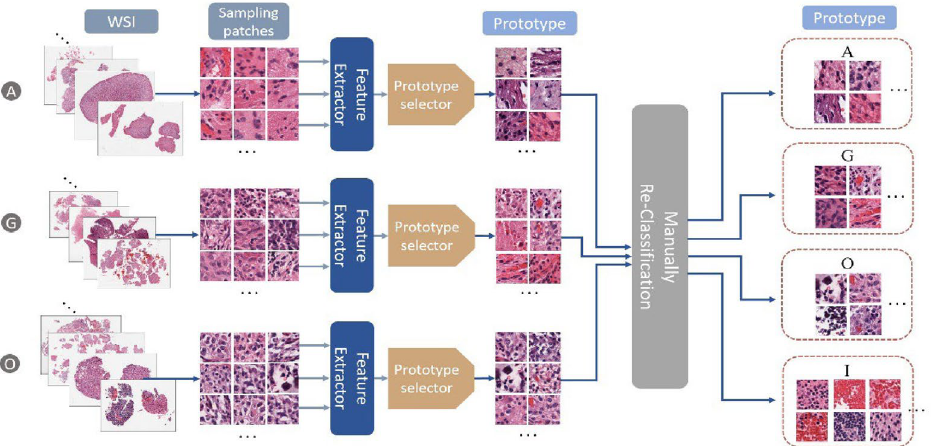
Figure 3. The pipeline of training phase in the WSI-based approach.